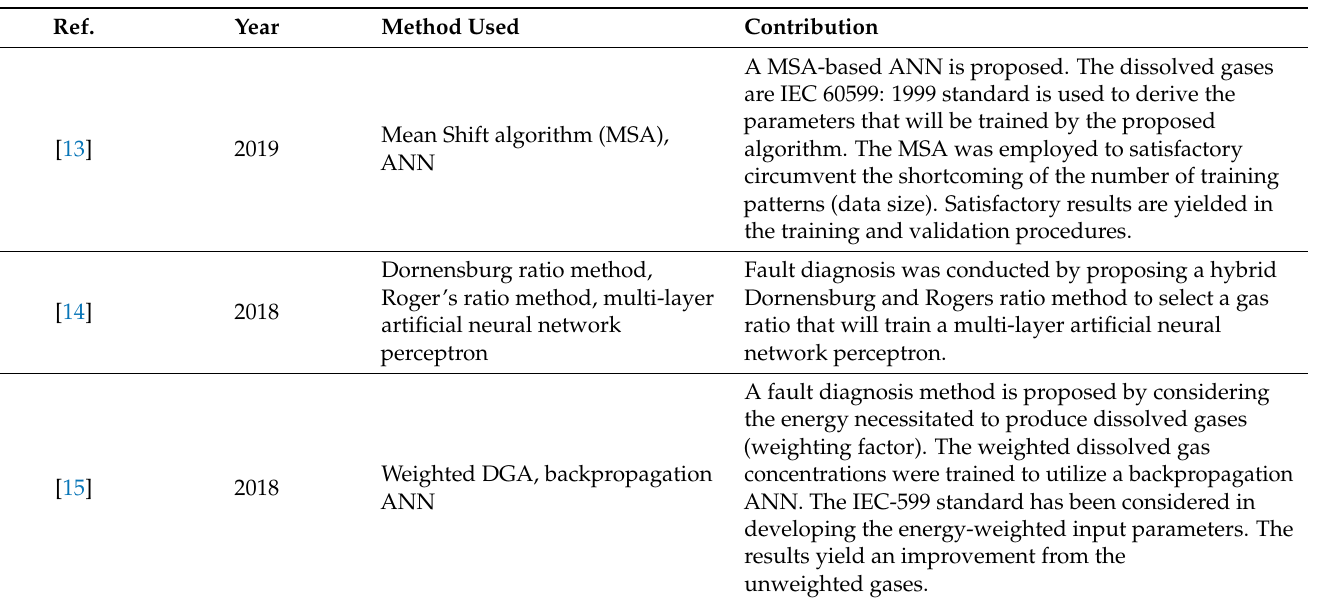
Table 1. Summary of recent related works.